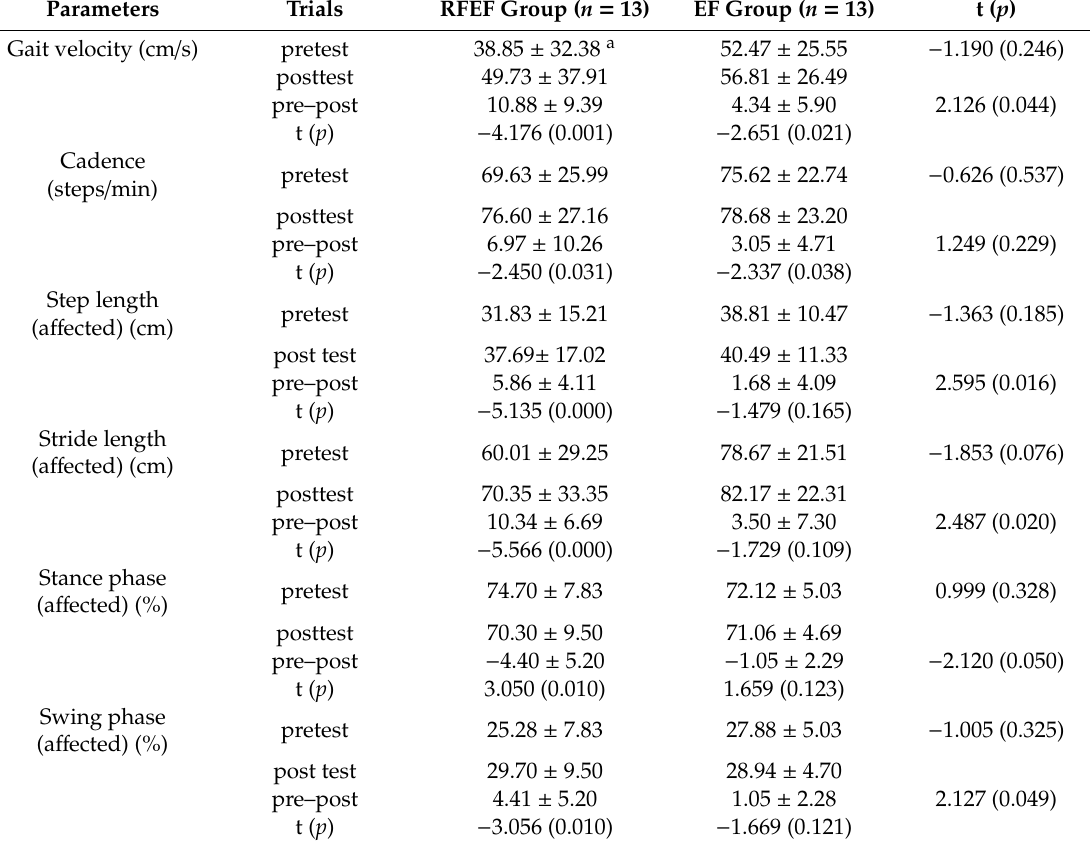
Table 4. Di ff erence in gait ability ( N =